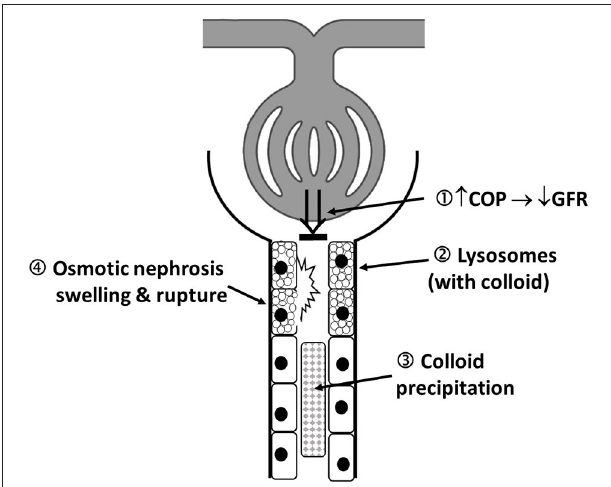
FIGURE 1 | Schematic illustration of proposed mechanism of colloid-induced AKI: 1. Colloid induced increase in plasma COP that decreases filtration pressure and consequently GFR (“hyperoncotic AKI”). 2. Accumulation of colloid containing proximal tubular lysosomes, leading cellular dysfunction. 3. Local hyperviscosity and colloid precipitation, forming of occluding casts. 4. Osmotic nephrosis represents vacuolization and swelling of the renal proximal tubular cells; It can be reversible, and function restored but may also be a first step in the development of irreversible cell lesions. The above mechanisms are not mutually exclusive and may occur in combination. AKI, acute kidney injury; COP, colloid osmotic pressure; GFR, glomerular filtration